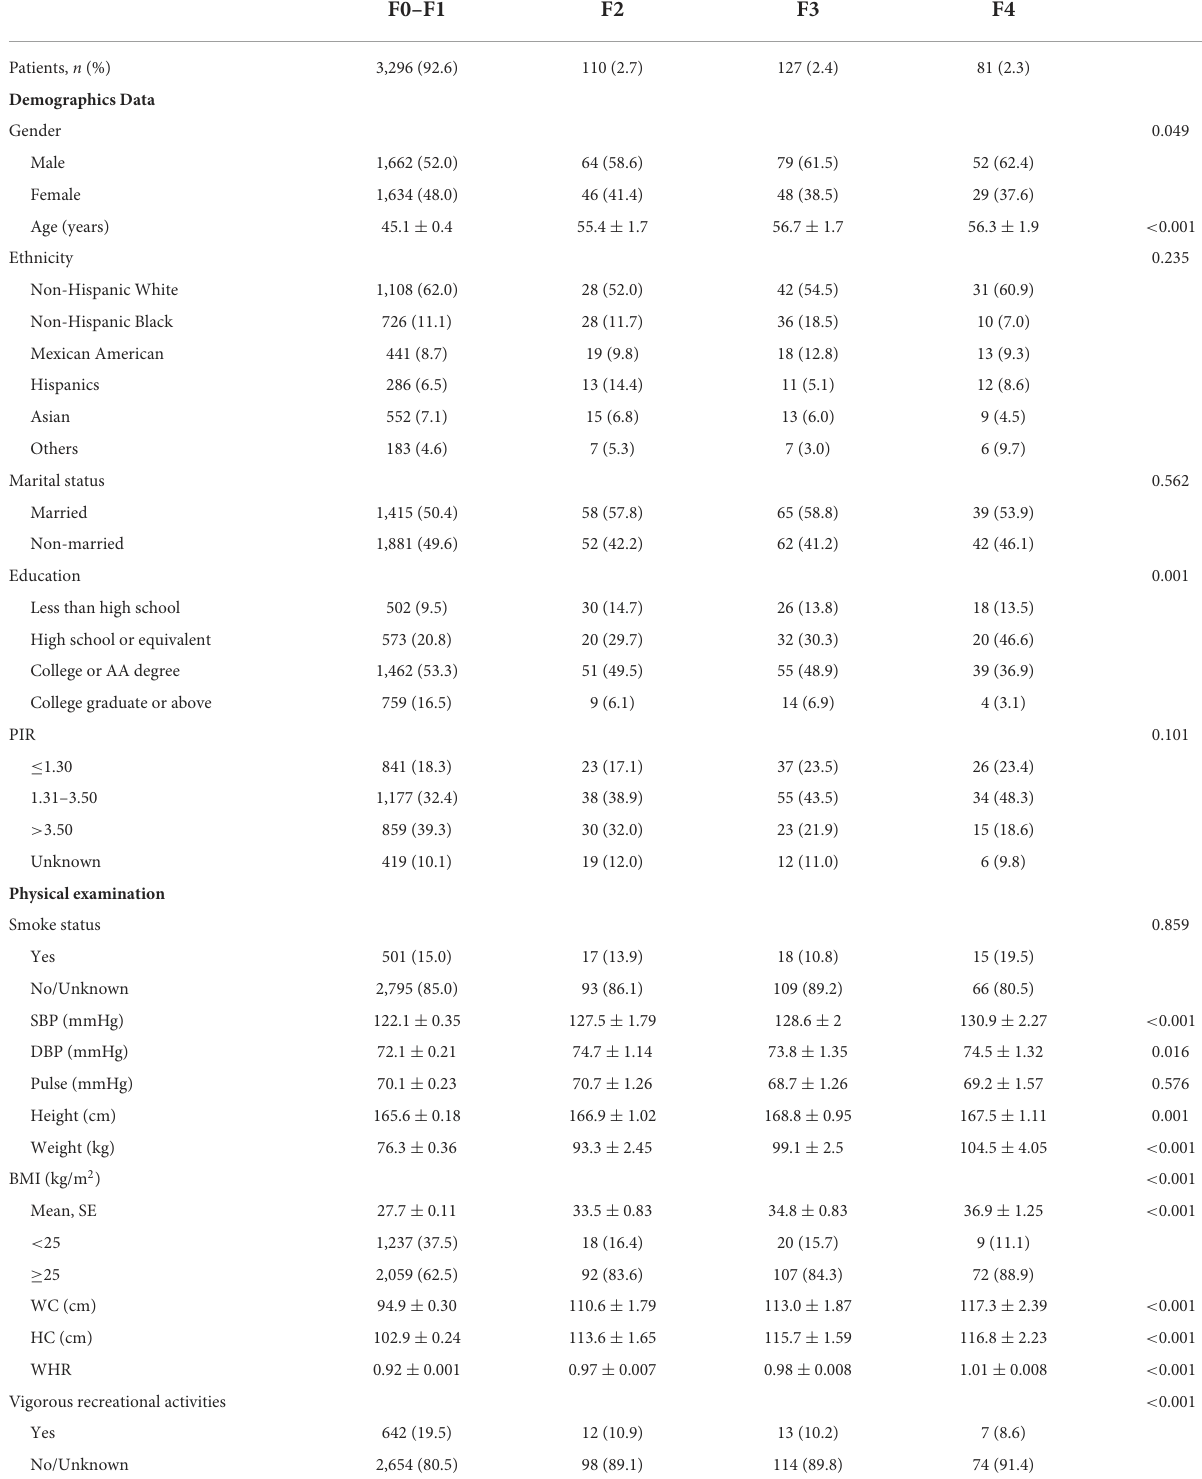
TABLE 2 Characteristics of the study population according to E values *